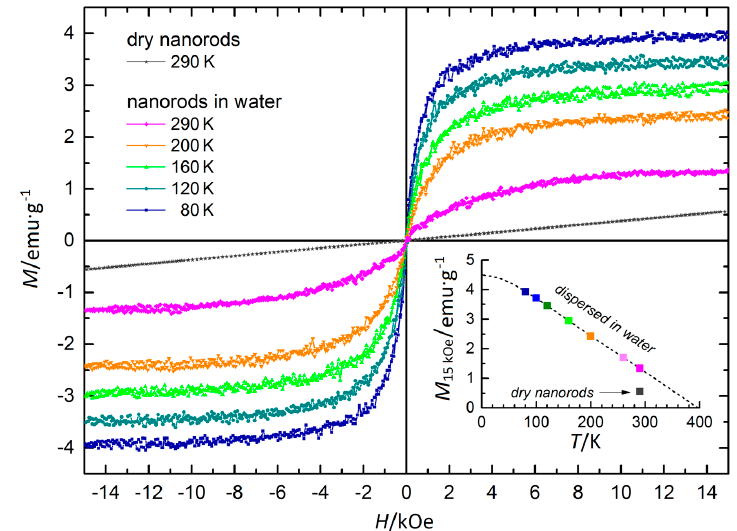
Figure 7. Magnetization curves of ZnFe 2 O 4 nanorods dispersed in water upon subtraction of diamagnetic contribution from solvent and container. Inset shows the dependence of high field magnetization versus temperature (line is a guide for the eye).